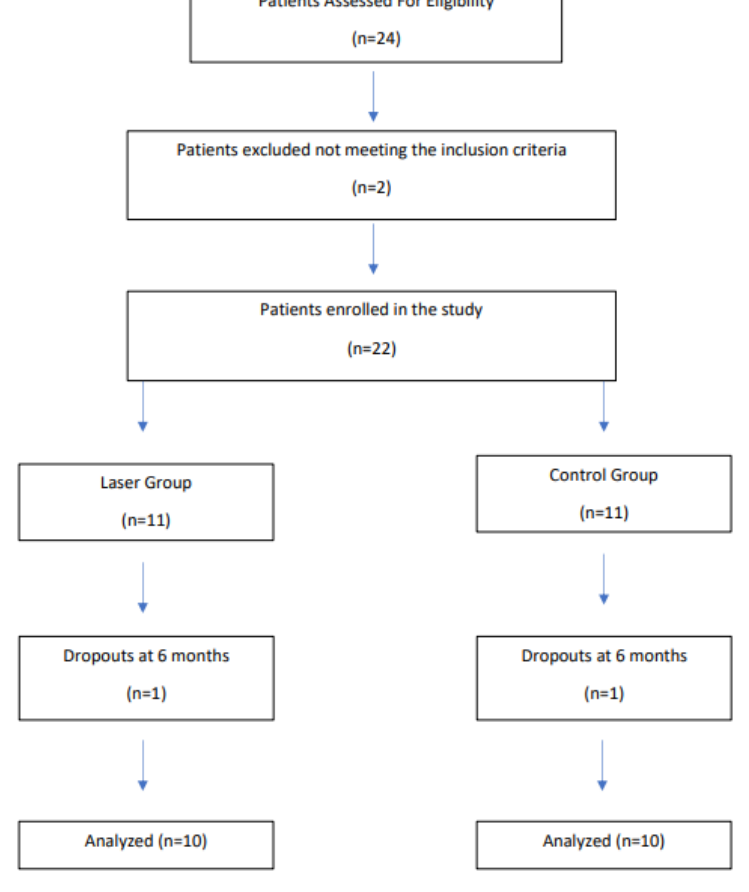
Figure 3. Patient Inclusion. Table 1. Baseline characteristics of the study patients.